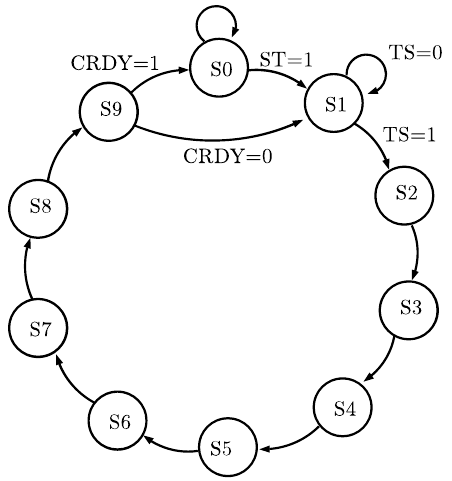
Figure A1. Discrete parabolic profile state